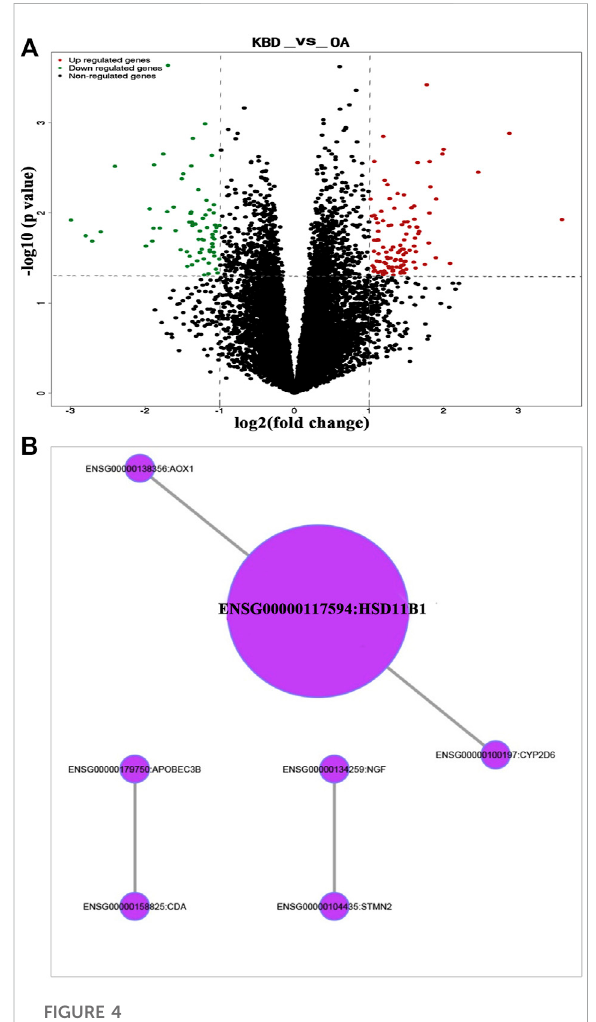
FIGURE 4 RNA sequencing analysis of differentially expressed genes in subchondral bone between patients with KBD and OA. (A) , Volcano plot fi ltering of the differentially expressed genes. The vertical lines represent – log10 ( p value), and the horizontal line represents log2 (fold change). The red and green points in the plot represent the up- and downregulated genes with statistical signi fi cance, respectively. (B) , Protein-protein interaction network ofthedifferentiallyexpressedgenesinsubchondralbonebetween patients with KBD and OA.